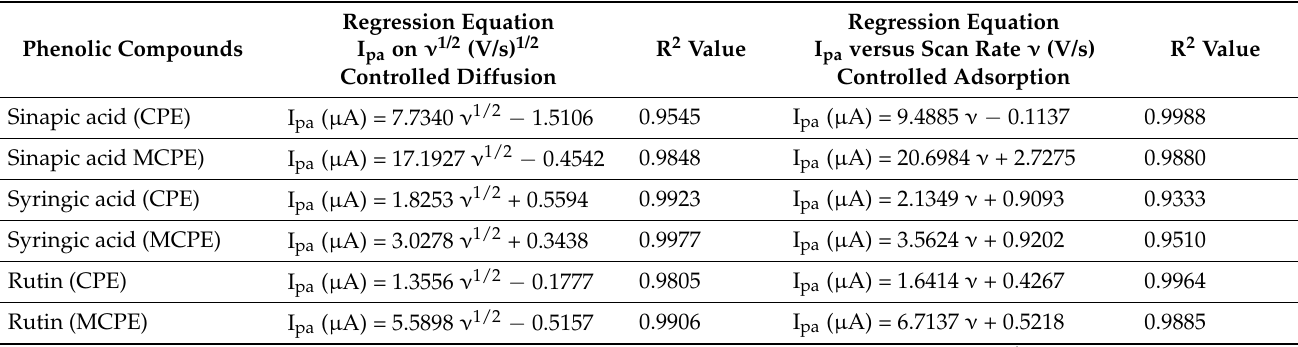
Table 2. Linear regression equations show the dependence of redox peak current Ip on the square root of scan rate ν 1/2 (V/s) 1/2 for controlled diffusion and dependence of redox peak current Ip on scan rate ν (V/s) for controlled adsorption for phenolic compounds at bare CPE and MCPE with their slopes and R-square